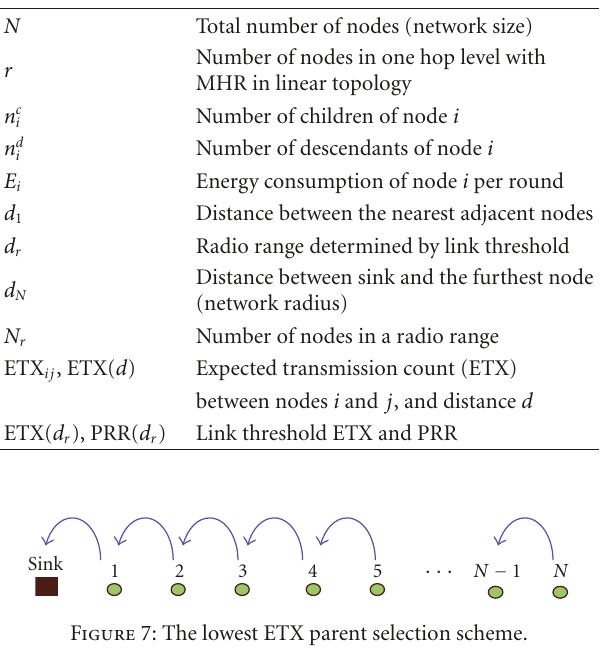
Table 1: Summary of notation.